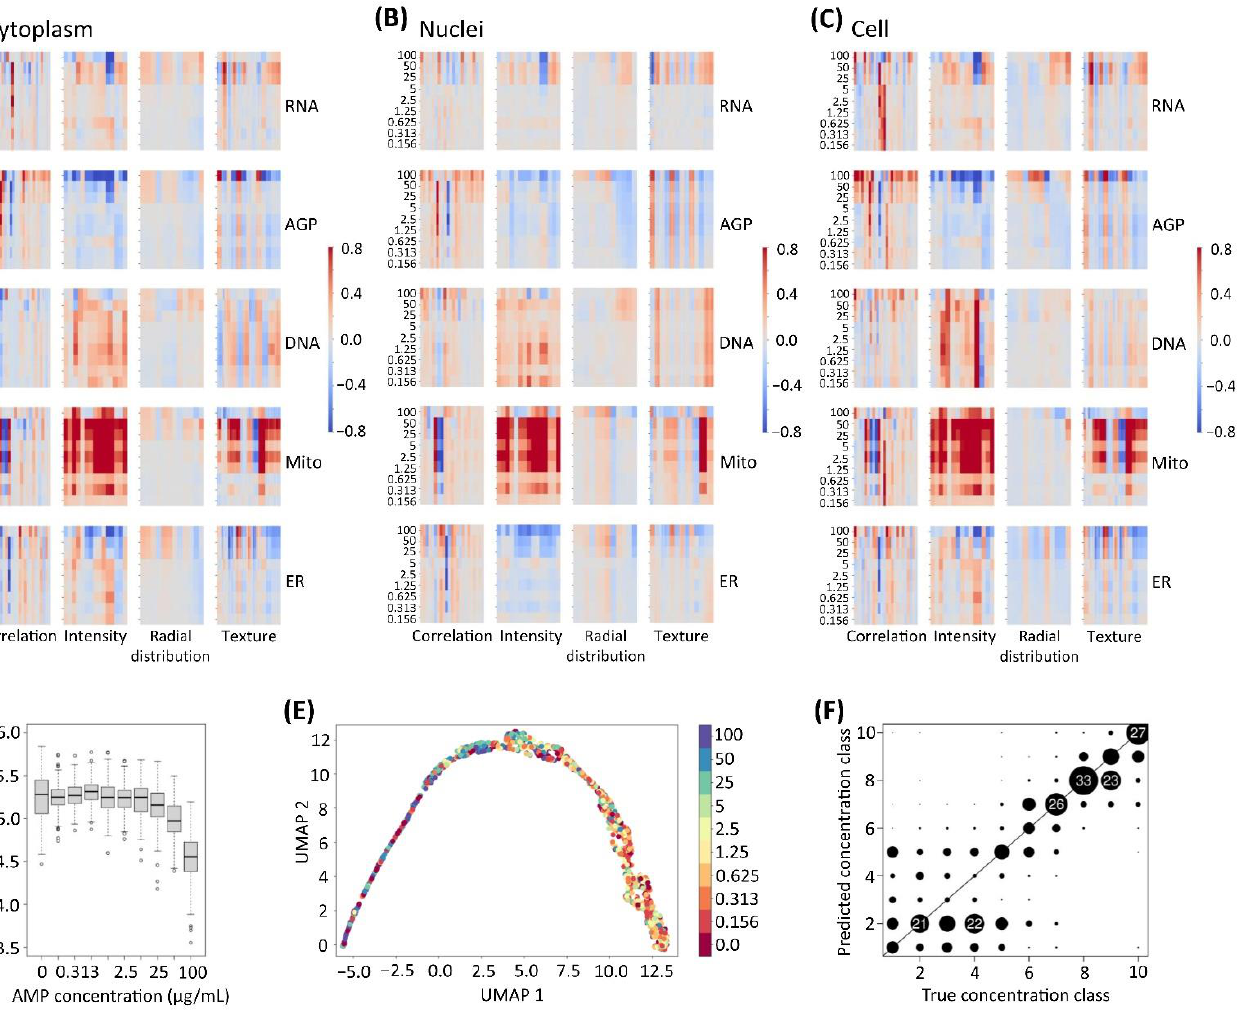
Figure 5. Quantitative summary of the morphological effects for the (nano)particles unintention- ally emitted at the metal AM occupational settings (AMPs). Treatment-level feature data were normalized and scaled per plate (N = 3), the batch effect was corrected, and then averaged. Three heatmaps were established, corresponding to the morphological features organized by compartment: ( A ) cytoplasm (962 features), ( B ) nuclei (976 features), and ( C ) cell (998 features); by feature group: correlation, intensity, radial distribution, and texture; and by fluorescent channel: nuclei (DNA), actin cytoskeleton/Golgi/plasma membrane (AGP), endoplasmic reticulum (ER), RNA/nucleoli (RNA), and mitochondria (Mito). The colors represent the fold change in each measured feature, with respect to the unexposed control cells. The rows correspond to the individual concentrations of the AMPs (0.156 – 100 µg/mL). Exposure concentrations are in descending order from top to bottom. Columns represent the individual morphological features. Data were derived from 435,678 single cell profiles distributed across six technical replicate wells of three microplates/biological rep- licates (N = 18 wells in total). ( D ) Boxplots for the feature Texture_Entropy_AGP_5_02_256 are shown as an example of a feature that is clearly dependent on the AMP concentration ( x -axis). ( E ) Uniform manifold approximation and projection (UMAP) was employed at the image level on the median of the morphological profiles of the U-2 OS cells exposed to the AMPs. Color legend indicates the AMP concentrations (µg/mL). ( F ) Results for the sparse partial least squares discriminant analysis (sPLS- DA) predictions averaged over three cross-validation runs, as a scatterplot. Predicted concentration class ( y -axis) is shown as dependent on the true concentration class ( x -axis). Circle radius visualizes